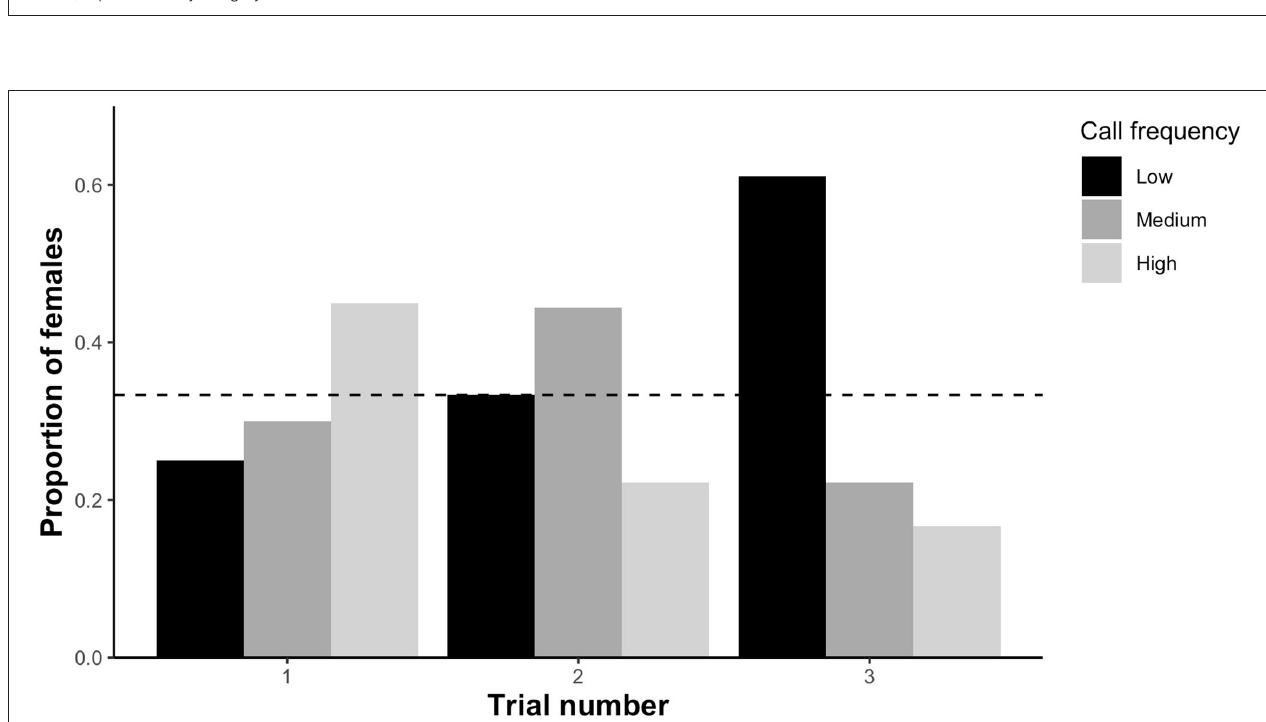
FIGURE 4 | The proportion of female P. corroboree choosing low, medium or high male call frequencies during each of the three trial rounds. Female overall preference was determined as the zone each female spent the most time in. Sample size for each trial as follows—trial 1: n = 40, trial 2: n = 18, trial 3: n = 18. Female overall preference was compared to an expected value of 0.33, represented by the dotted horizontal line.